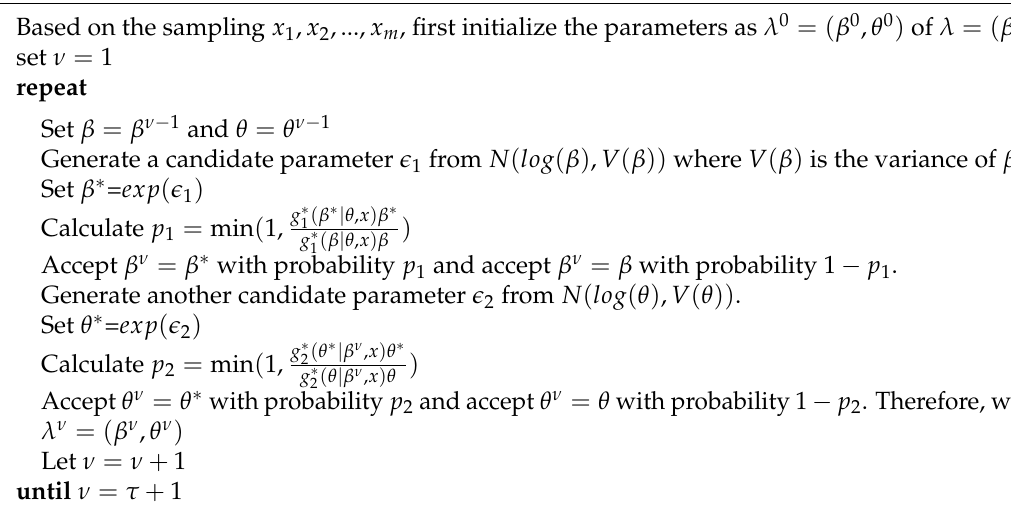
Algorithm 1 Gibbs sampling with Metropolis-Hastings algorithms.